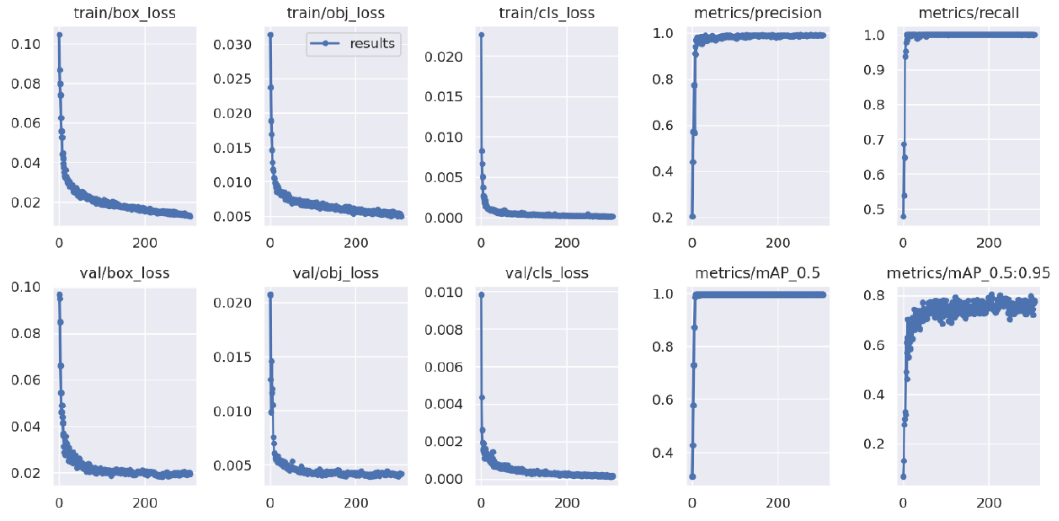
Figure 12. Metrics during YOLOv5 training.